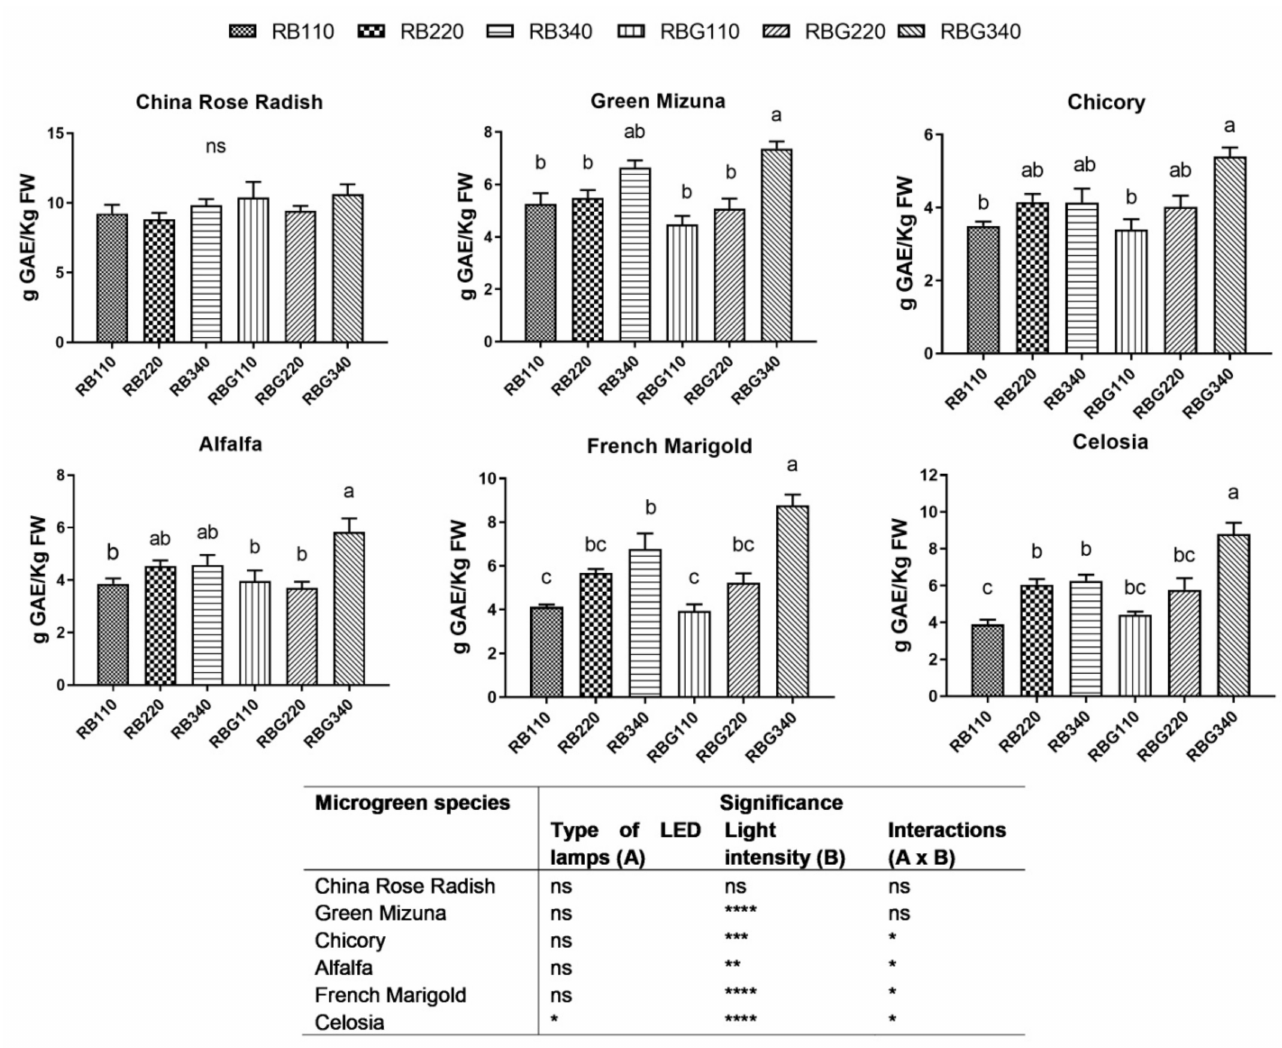
Figure 2. Total phenol content from six microgreen species affected by different light environments. Data are shown as means with at least five independent biological replicates and error bars indicate standard error (SE). Data were subjected to two-way analysis of variance and differences were analyzed by Tukey’s post-hoc. Different letters denote significant differences at p < 0.05. Levels of significance of the parameters assessed for each microgreen species considered where: ns, *, **, ***, ****, are not significant, significance at p < 0.05, 0.01, 0.001, and 0.0001 respectively. When there was not significant A × B interaction, the effect of light spectra (A) and light intensity (B) was evaluated separately using one-way ANOVA and t -test, respectively (Supplementary Table S1). Different letters on the histograms within each light spectrum (RB and RGB) indicate significant differences among light intensity (Tukey’s test, p <